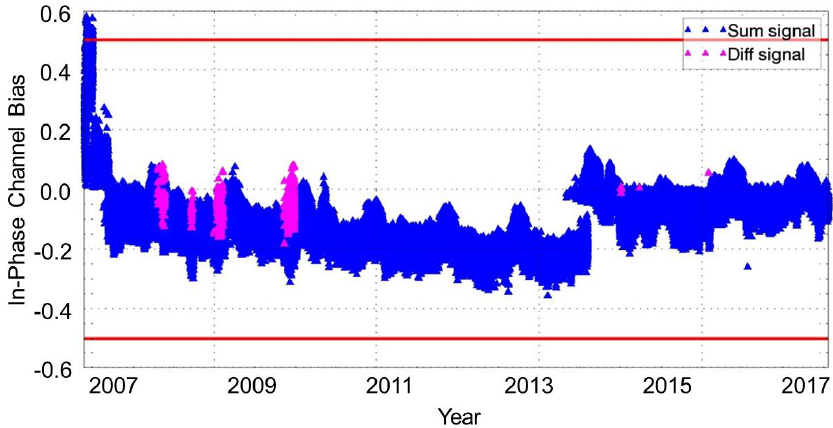
Figure 16. Bias of the In-phase Channel and its readjustment in 2014.